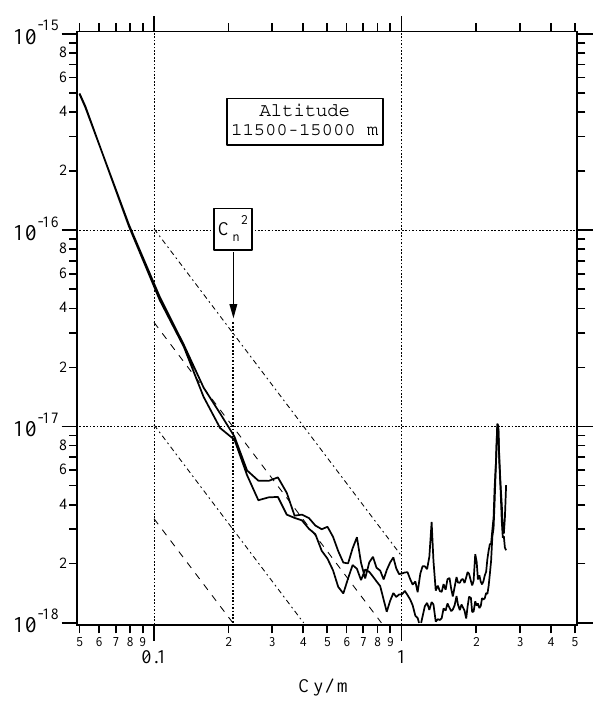
Fig. 1. Refractivity spectrum in the 11.5–15 km altitude range ob- tained from high resolution in-situ temperature and pressure mea- surements on 27 April. The wavenumber for which the spectrum is numerically equal to the mean C 2 n value is shown as a vertical dotted